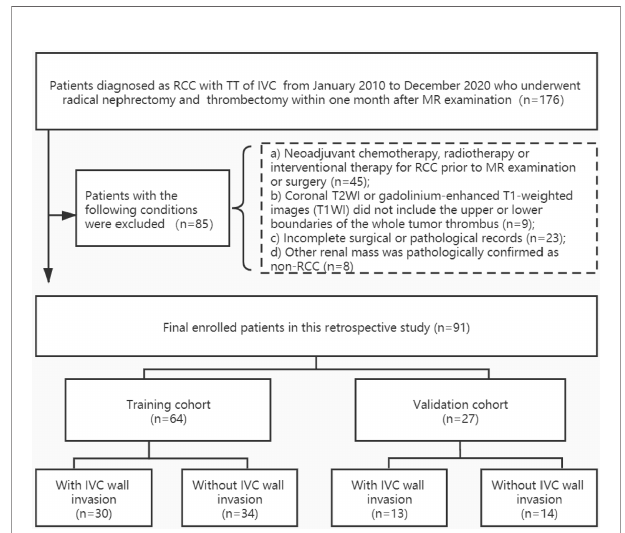
FIGURE 1 | Patient enrollment folw chart. RCC, renal cell carcinoma; TT, tumor thrombus; IVC, inferior vena cava. Other renal mass include four angiomyolipoma, one in fl ammatory myo fi broblastic tumor, one synovial sarcoma, one malignant solitary fi brous tumors, and one primitive neuroectodermal